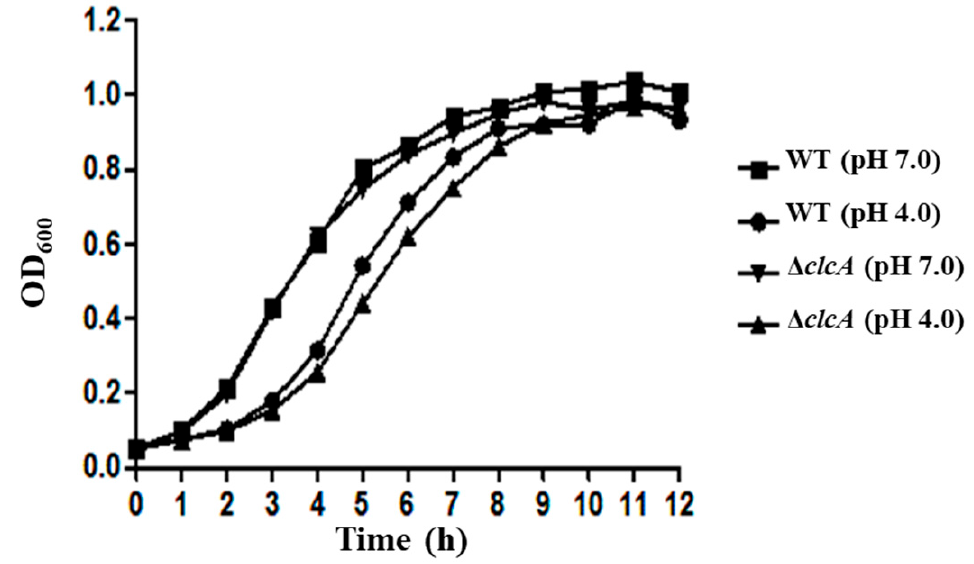
Figure 4. Growth curves of WT and ∆ clcA in LB medium at pH 4.0 and pH 7.0. The overnight cultures of WT or ∆ clcA were diluted to a new LB medium at pH 4.0 and pH 7.0, respectively. Then, the bacteria were cultured at 37 ◦ C with 180 rpm, the OD 600 values were detected at the indicated time points. The experiments were repeated three times.